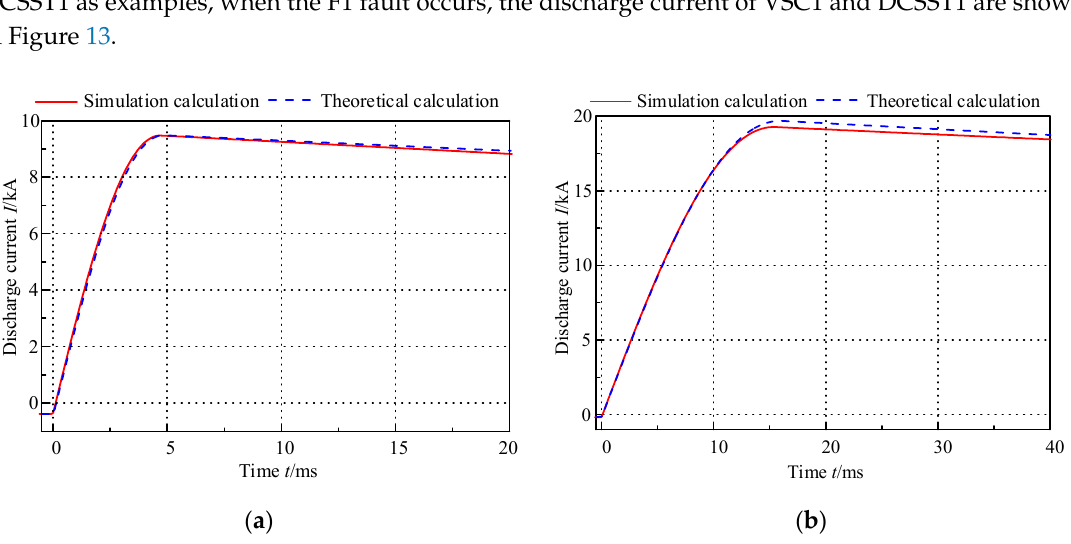
Figure 13. The current waveform under F1 fault by theoretical calculation and simulation calculation: (a) VSC1 discharge current and (b) DCSST1 discharge current.